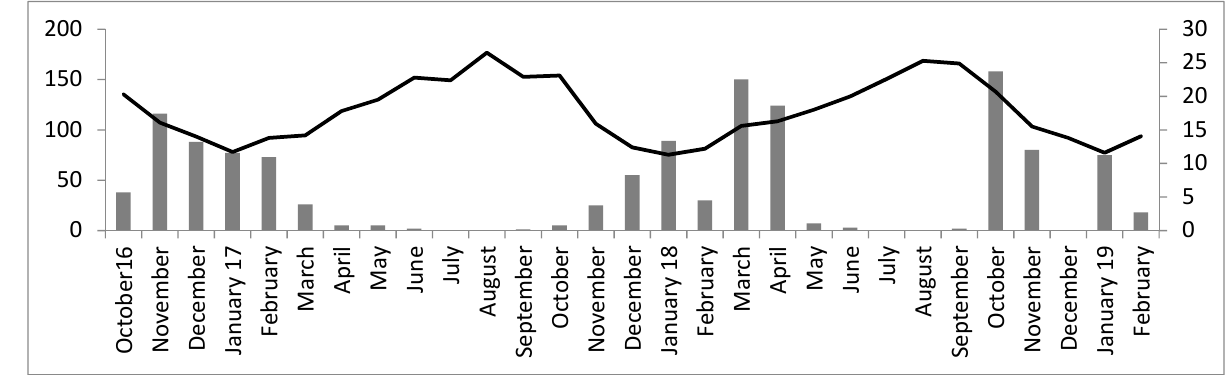
Figure 1. Climatic diagram: in black the precipitation (mm) and in grey mean average temperature (°C).